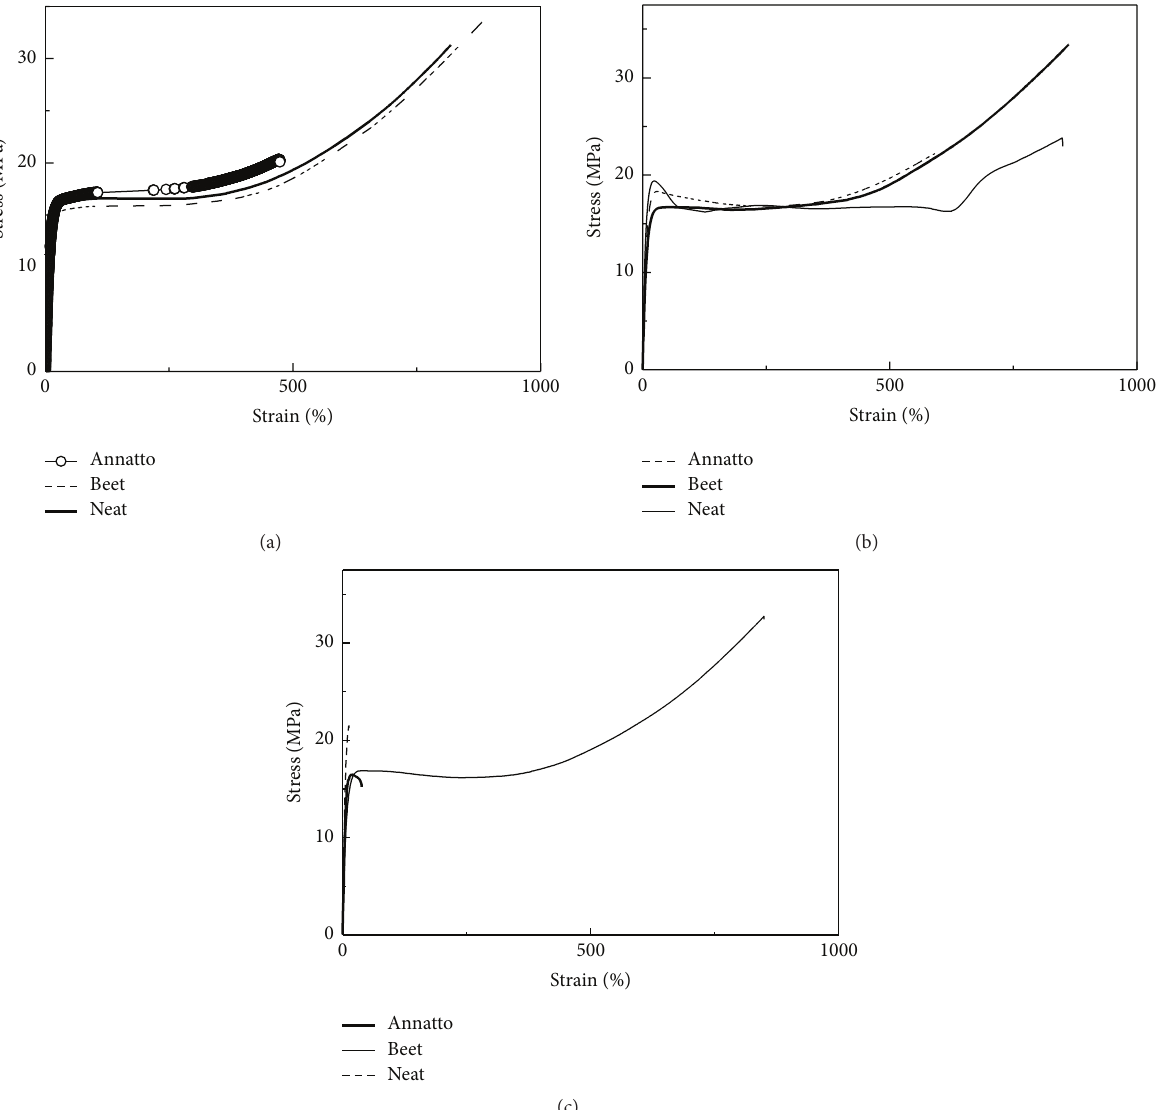
Figure 8: Stress strain curves for different compositions. (a) Unexposed, (b) 21 days of UV exposure, and (c) 42 days of UV